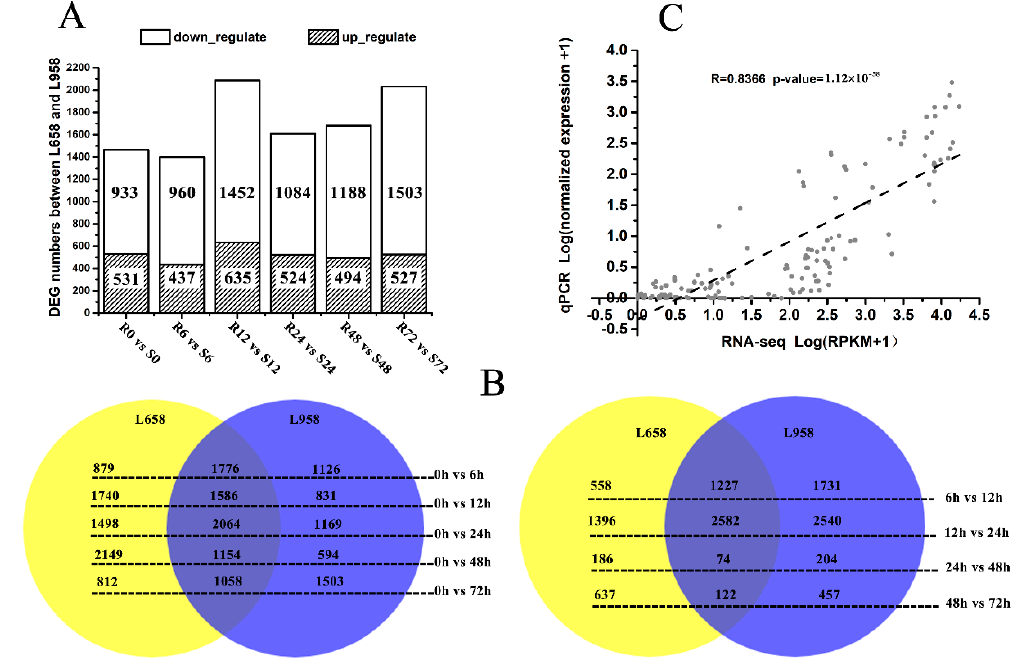
Figure 1. Number of differentially expressed genes (DEGs) in different comparisons and reliability of RNA-seq data as demonstrated by quantitative real-time PCR (qRT-PCR). ( A ) Number of DEGs between L658 (R) and L958 (S) at different inoculation time points; ( B ) Venn diagram showing the number of DEGs shared between (overlap) and specific to L658 (yellow) and L958 (blue) at various inoculation time points compared with 0 h (left) and between two adjacent time points (right); and ( C ) correlations between normalized RNA-seq reads per kilobase per million (RPKM) values and normalized qRT-PCR expression values. The scatterplot shows the log10 of RPKM values + 1 and the log10 of qRT-PCR expression values + 1; a trend line is shown as the dotted line.